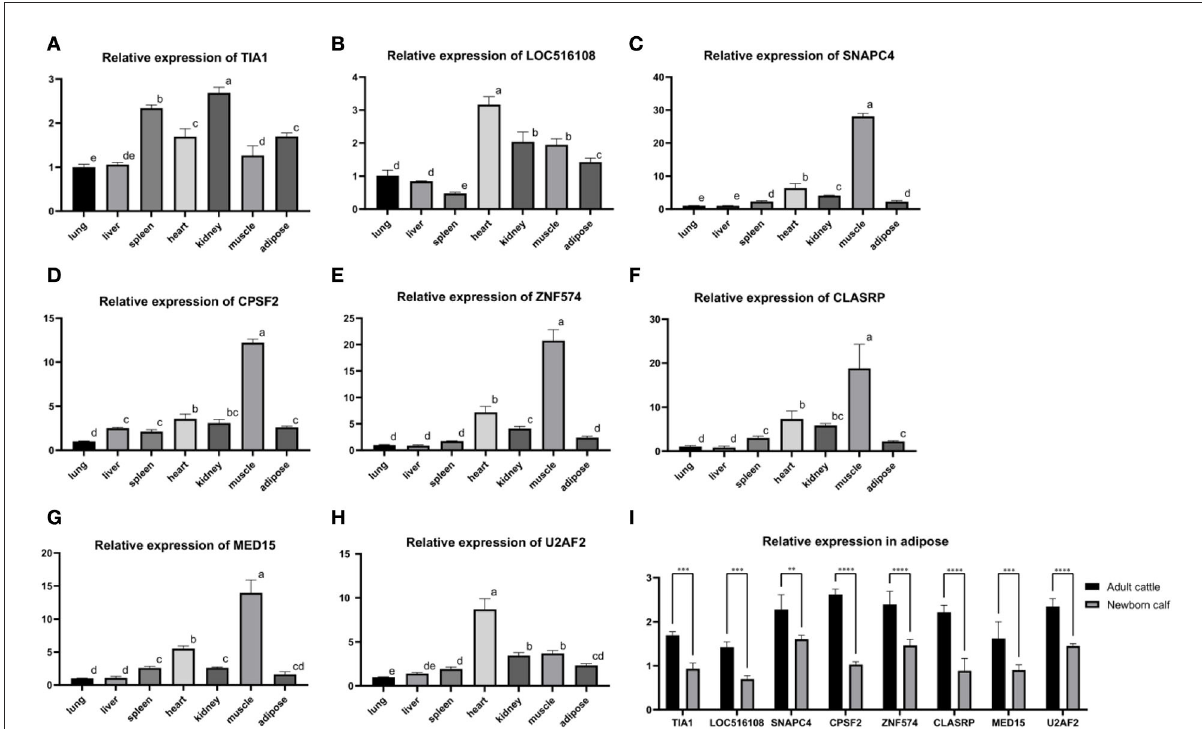
FIGURE6 The tissue expression profile of 8 hub genes. (A) Tissue expression profile of TIA1 . (B) Tissue expression profile of LOC516108 . (C) Tissue expression profile of SNAPC4 . (D) Tissue expression profile of CPSF2 . (E) Tissue expression profile of ZNF574 . (F) Tissue expression profile of CLASRP . (G) Tissue expression profile of MED15 . (H) Tissue expression profile of U2AF2 . Superscript letters indicate mean significant difference ( p < 0.05). Values with superscript letters indicate a mean significant difference ( p < 0.05). (I) Relative expression of adult cattle and newborn calf in adipose. *Denotes significance according to ANOVA methods, * p < 0.05, ** p < 0.01, *** p < 0.001, and **** p <